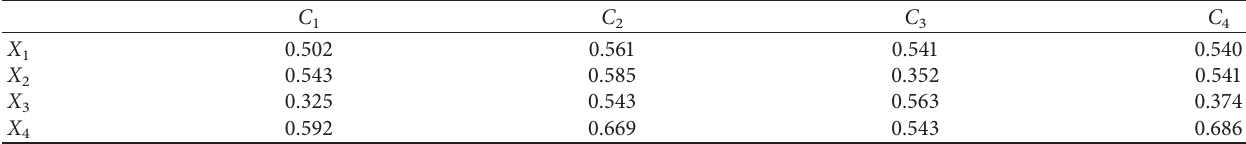
Table 8: Defuzzified centroid matrix Z .